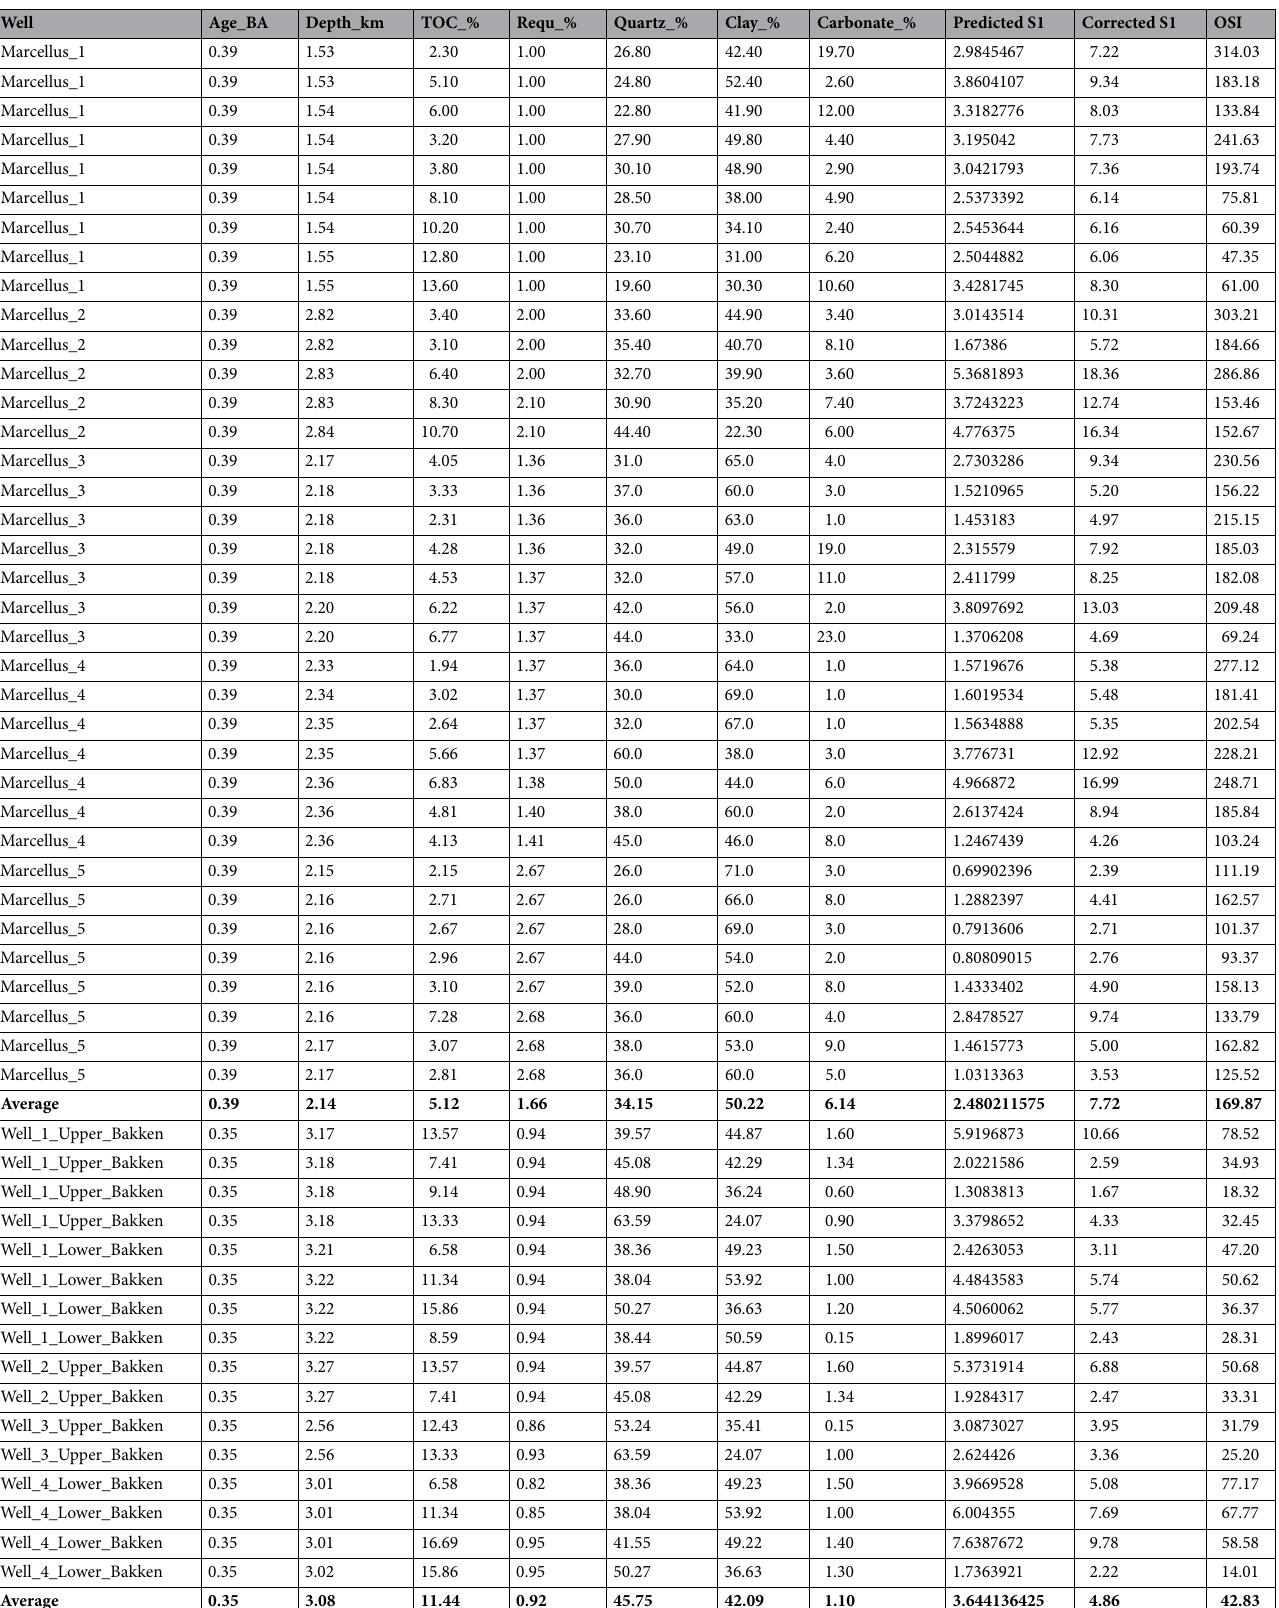
Table 3. Prediction dataset of the Bakken and Marcellus shales and, predicted S1 volumes, evaporation loss corrected S1 volumes and OSI based on the DL model. TOC, Total organic carbon content; Requ, Vitrinite reflectance equivalent; S1, Fluid oil and gas volumes as mg HC/g TOC; OSI, Oil saturation index as mg oil/g